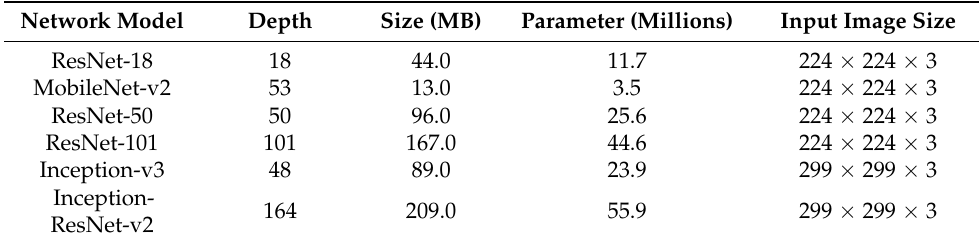
Table 2. Properties of pre-trained convolutional neural networks